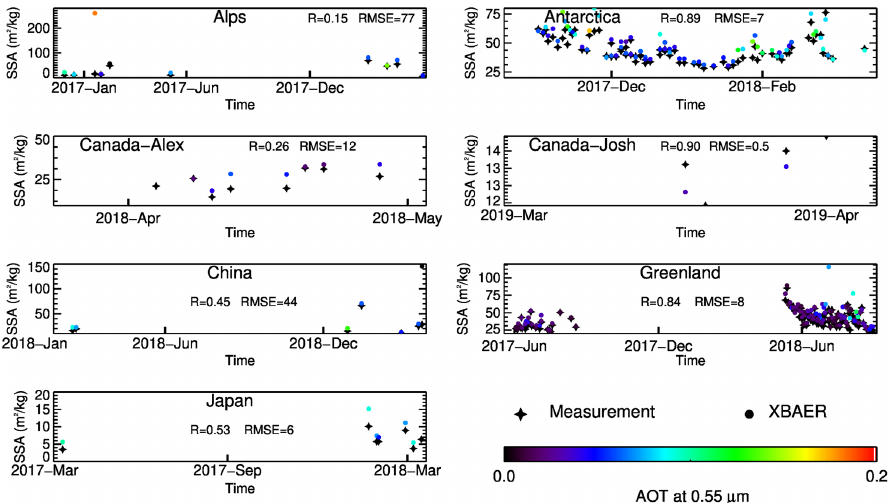
Figure 10. Time series of XBAER-derived and field-measured SSA for each site. The match-ups for SGS are distinguished by the AOT values. The correlation coefficient ( R ) and the RMSE (m 2 /kg) are given.